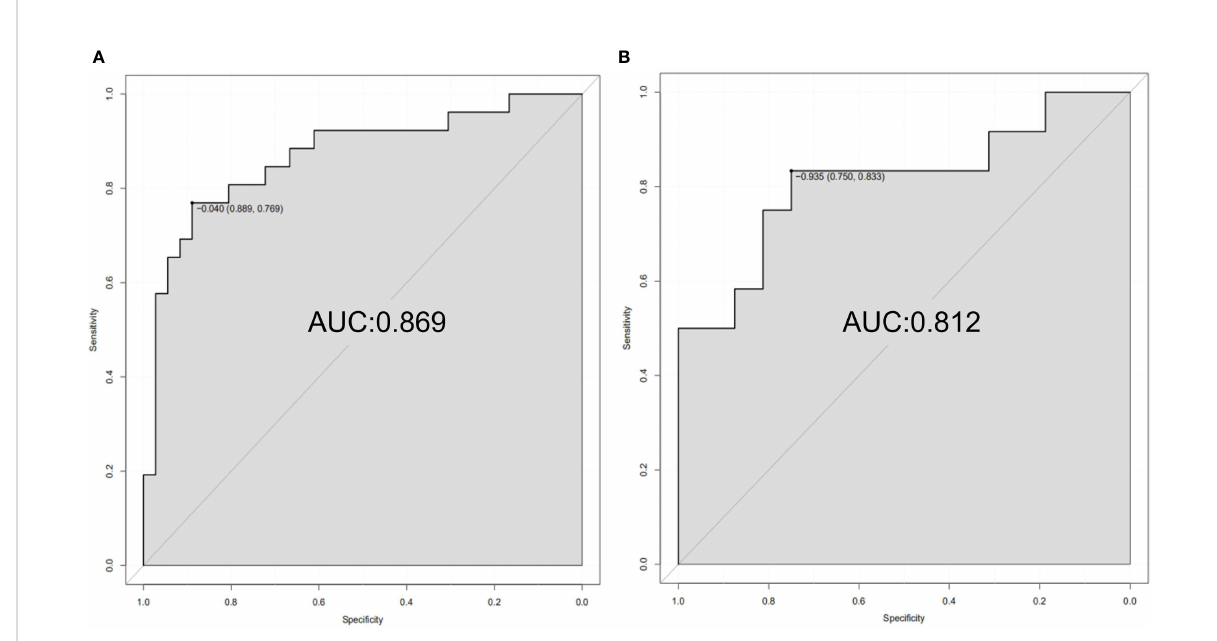
FIGURE 4 ROC curves of the combined nomogram in training (A) and Validation Cohorts (B)